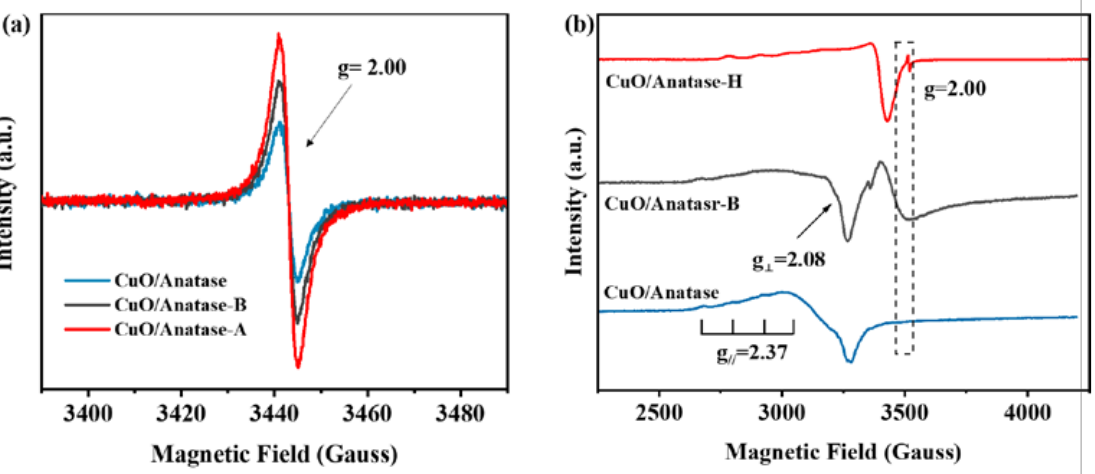
Figure 6. EPR of CuO/anatase, CuO/anatase-B and CuO/anatase-H catalysts. ( a ) EPR signal of oxygen vacancy; ( b ) EPR signal of Cu species and oxygen vacancy.